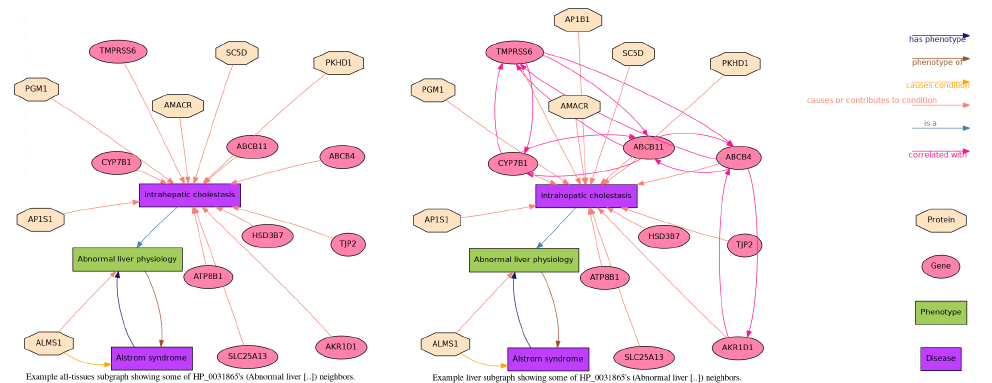
Figure 2. Example subgraph from the general (all tissues) KG compared to the same set of nodes in the liver KG. The handful of nodes displayed here illustrate the richness of relations among concepts and entities. The subgraph in the liver-specific KG includes several additional gene<->gene edges which are only derived empirically from liver samples, not when using all samples across tissues. It also features an additional protein edge connecting to one of the disease nodes ( AP1B1 to intrahepatic cholestatsis